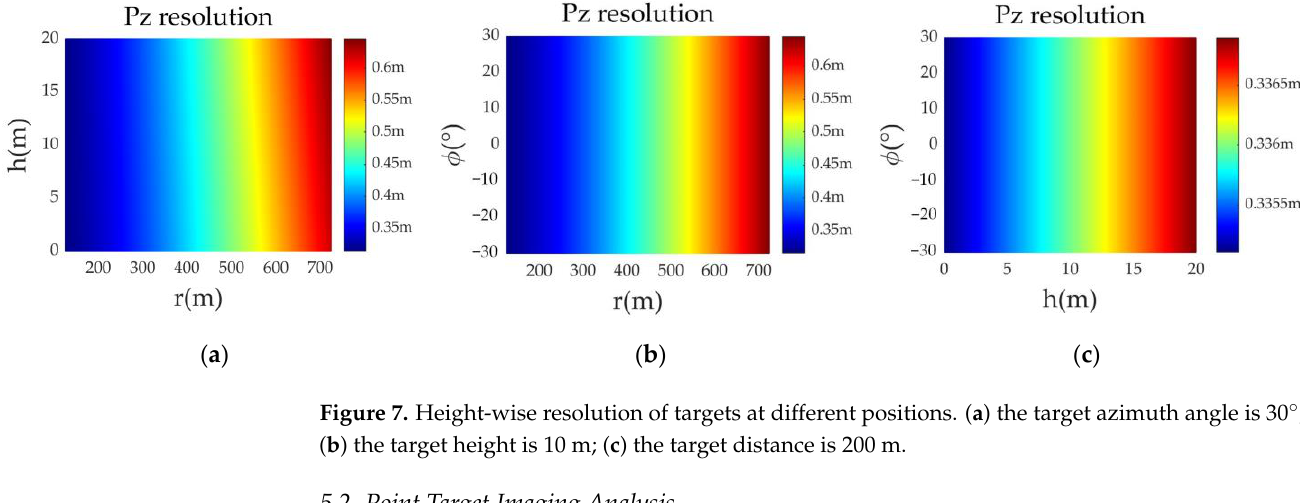
( b ) Figure 8. Multi-point target position and the imaging result of targets. ( a ) Multi-point target distri- bution location map; ( b ) 3D imaging results of multi-point targets. Point targets P5 and P9 were selected for measurement and analysis to further verify the effectiveness of the proposed imaging method. Figure 9 shows the single-point 3D imaging of point targets P5 and P9, which shows that the imaging point target has good focusing performance.